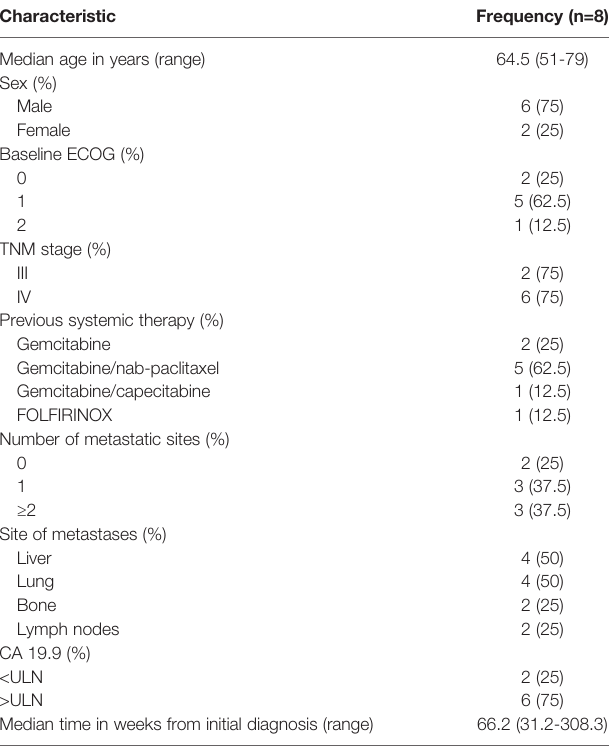
TABLE 2 | Baseline patient characteristics.